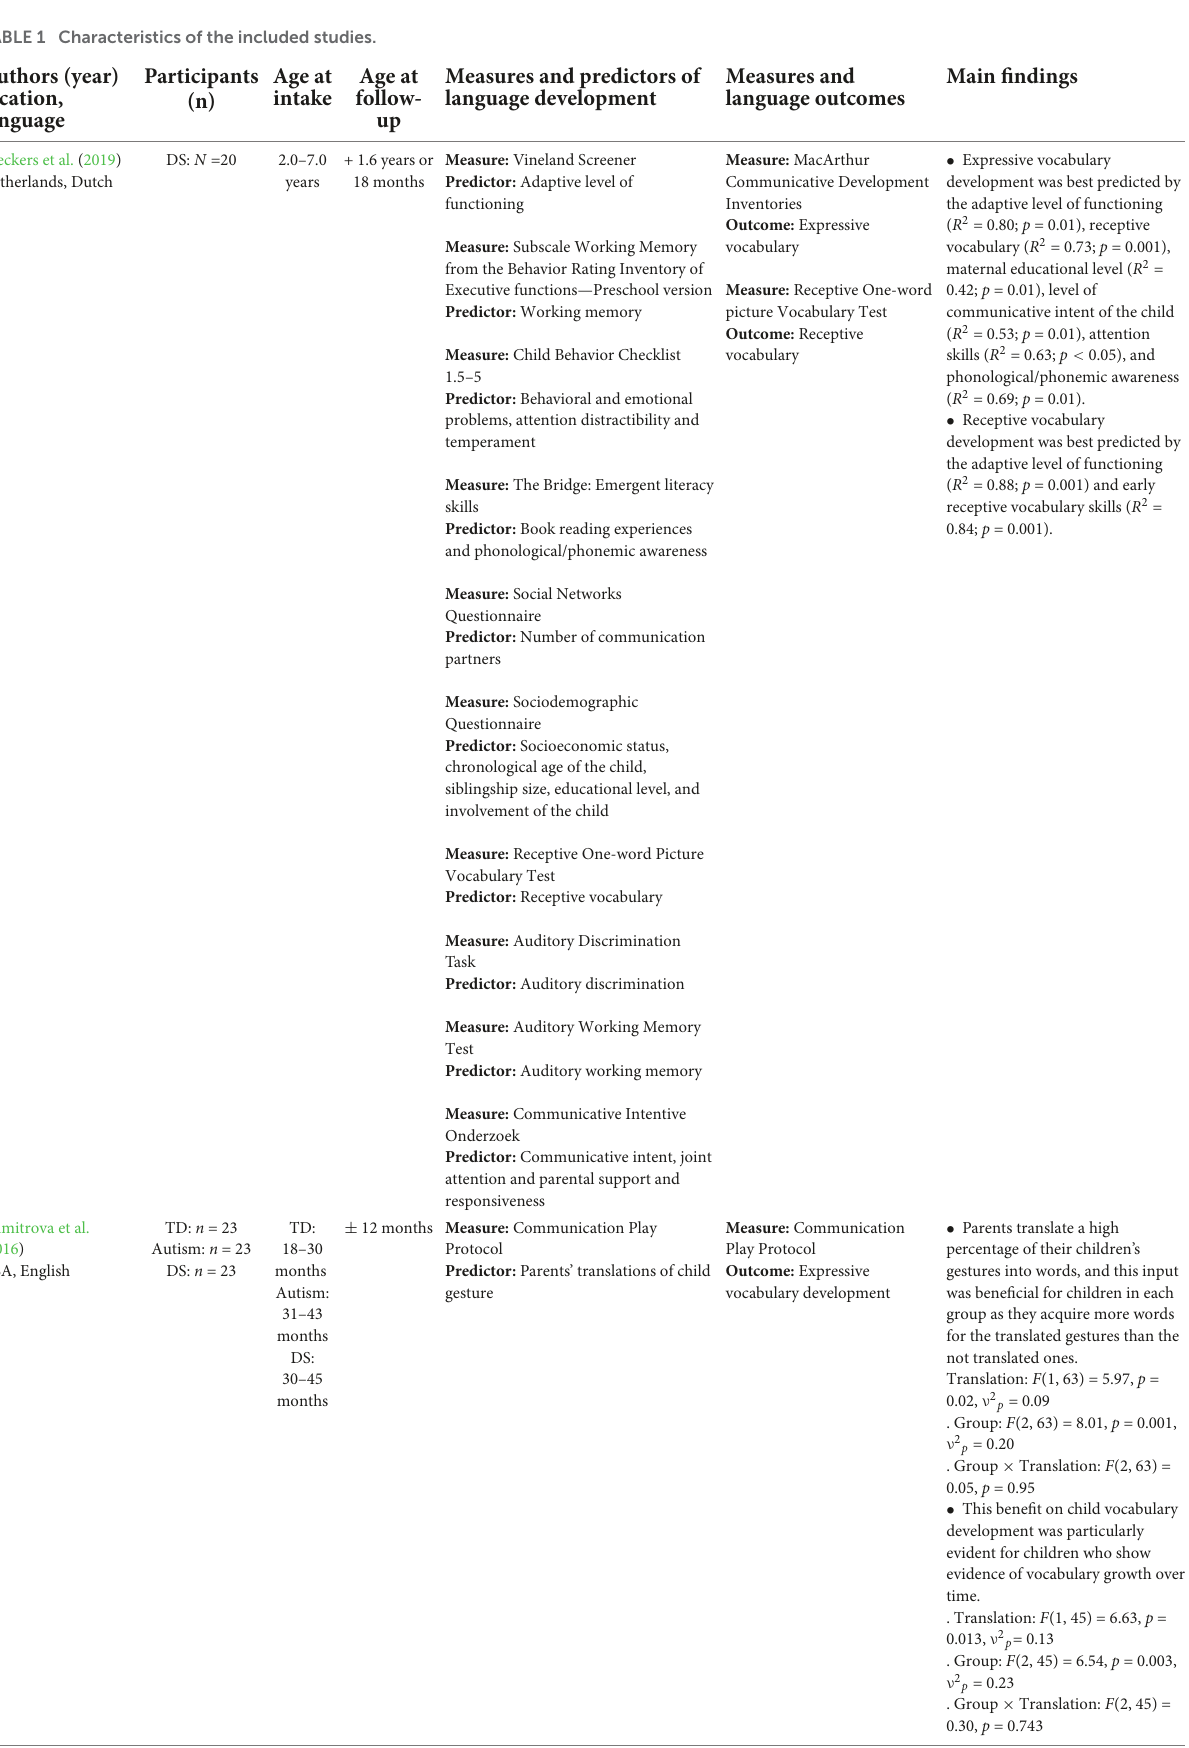
TABLE 1 Characteristics of the included